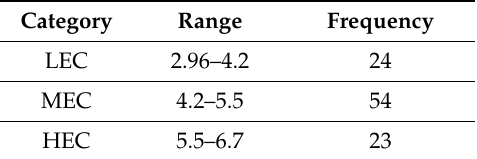
Table 7. Respondent distribution as per energy